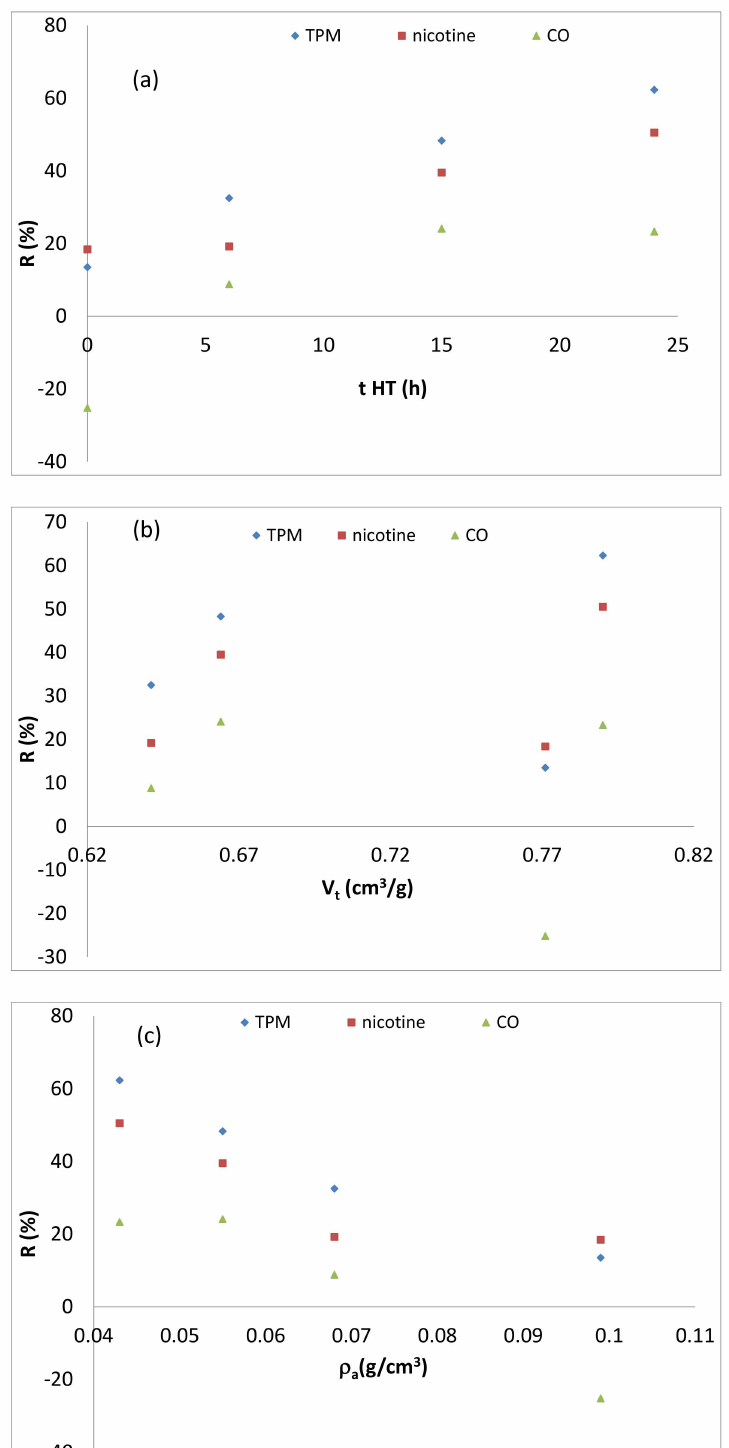
Figure 5. Reduction (R) of TPM, nicotine and CO yields vs.: ( a ) hydrothermal treatment time (tHT), ( b ) total pore volume Vt and ( c ) apparent density ρ a